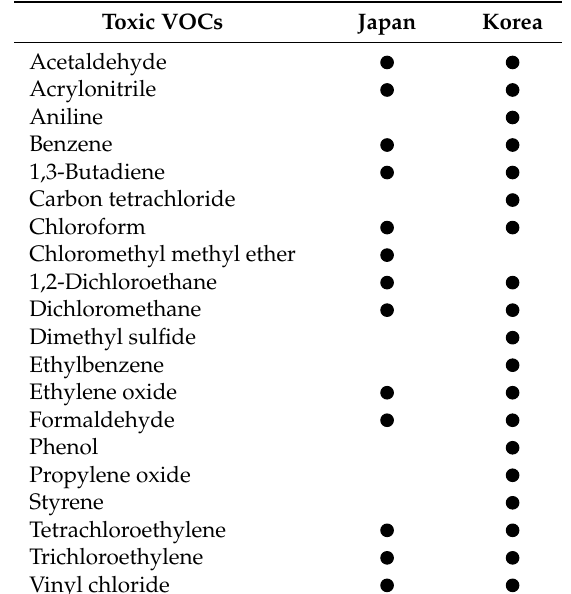
Table 2. Summaries of toxic volatile organic compounds (VOCs) designated as HAPs in Korea and Japan. means that this VOC is desiganted as HAPs in Korea and/or